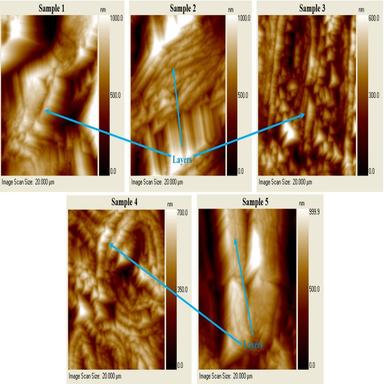
Scanning probe microscopy images of individual RH biomasses (without being integrated in the composite). The micrographs show the layered nature of all the rice husk samples along with the indentation mark left by the Berkovich tip. (For interpretation of the references to colour in this figure legend, the reader is referred to the web version of this article.)